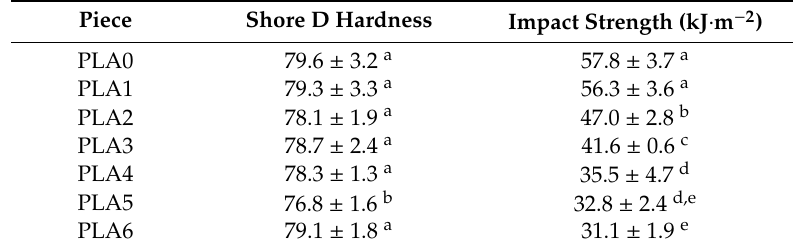
Table 2. Mechanical properties of the injection-molded polylactide (PLA) pieces subjected to di ff erent reprocessing cycles in terms of D Shore hardness and impact